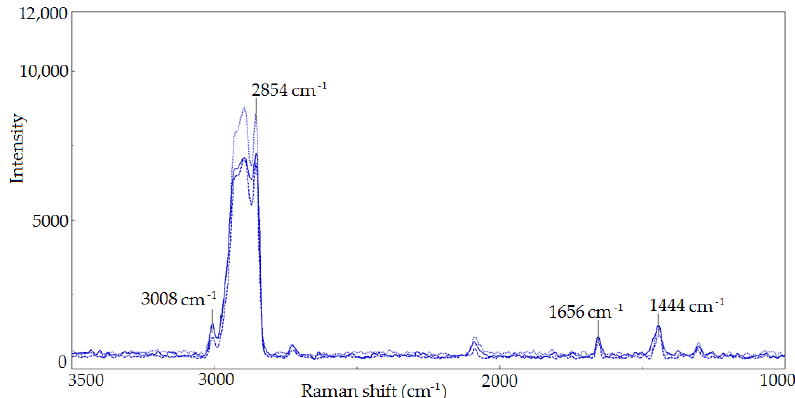
Figure 4. Raman spectra of A_CO 2 oil (blue line), A_CO 2 _80 oil, oxidized at 80 ◦ C (—– blue line) and A_CO 2 _120 oil, oxidized at 120 ◦ C ( blue line), in the 3500 cm − 1 –1000 cm − 1 range.